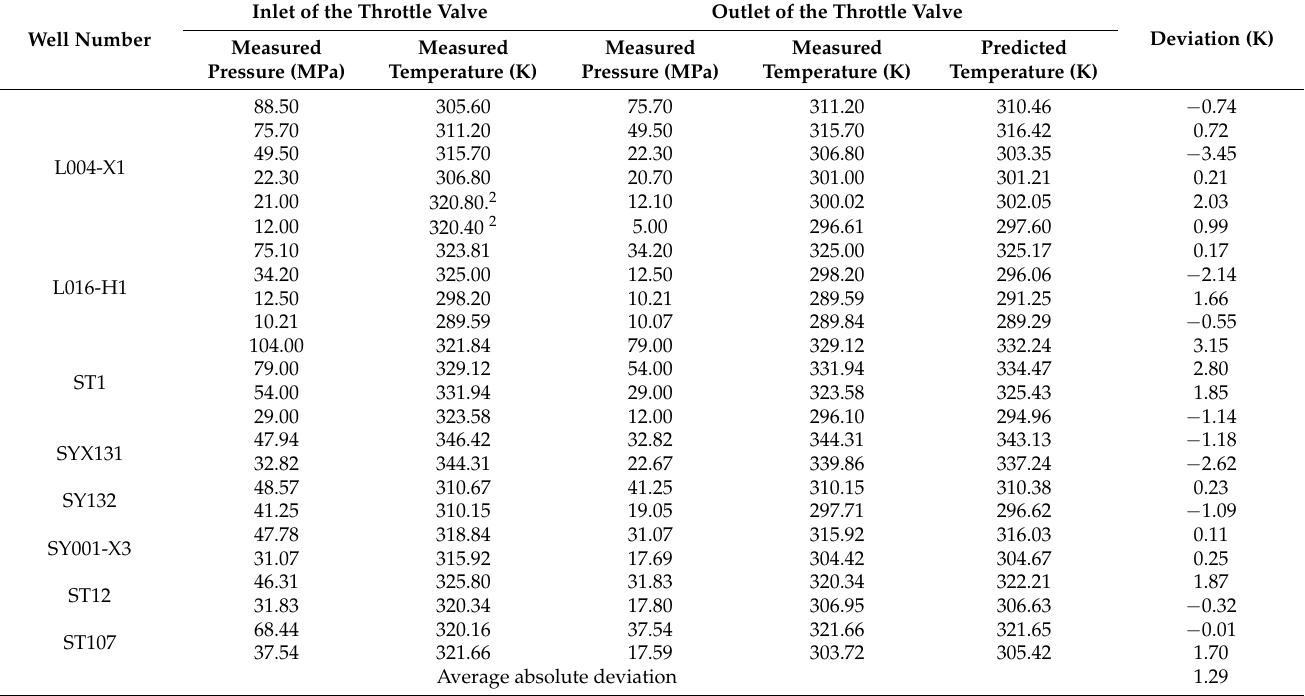
Table 6. Comparison between predicted and measured throttling temperature 1